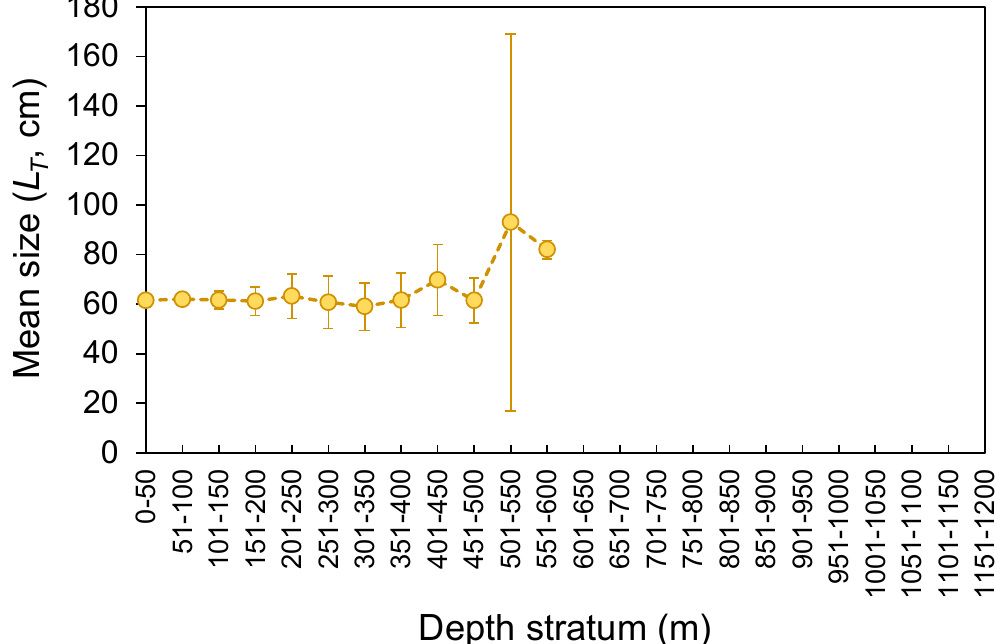
Figure 4. Depth distribution of mean ( ± 0.95 confidence interval) total length ( L T ) of the thornback ray Raja clavata caught during scientific surveys (1996 – 2019) in the Azores.